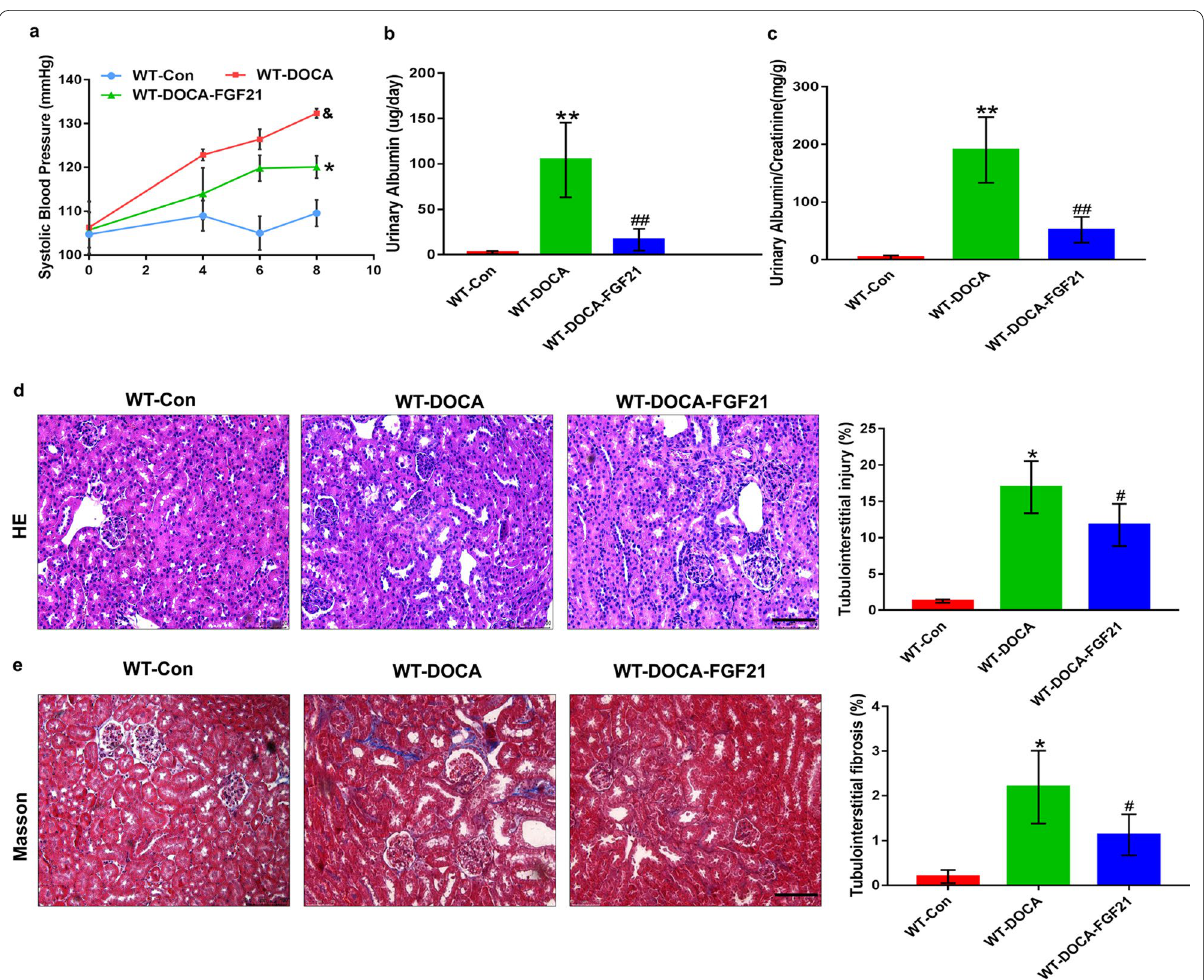
Fig. 3 Replenishment of rhFGF21 effectively protected mice from DOCA‑salt‑induced renal injury. Eight‑week‑old male WT mice were randomly divided into three experimental groups: the WT‑Control group treated with sham operation, followed by intraperitoneal injection with 0.9% normal saline; the WT‑DOCA group treated with DOCA‑salt; the WT‑DOCA‑FGF21 group treated with DOCA‑salt, followed by intraperitoneal supplementation of recombinant human FGF21 (rhFGF21, 500 μg/kg/day body weight). After 8 days of intervention, the serum and kidney tissues of mice in each group were harvested for detection. a Systolic blood pressure (mm Hg) was determined at the indicated days (from 0 to 8 day). b and c Urinary albumin (μg/day) and the ratio of urinary albumin/creatinine (mg/g) as indexes of renal function were determined. d Representative images of Hematoxylin–eosin staining in kidney tissues collected at 8 days post‑DOCA‑salt treatment and quantification of tubulointerstitial injury region using Image‑Pro plus 6.0 software. e The levels of fibrosis in kidney tissues harvested at 8 days post‑DOCA‑salt treatment was determined by Masson’s trichrome staining and quantification of fibrotic degree in tubulointerstitium using Image‑Pro plus 6.0 software. The values are expressed as the mean SD, n 6 mice/group. *P < 0.05 and **P < 0.01versus the WT control group; # P < 0.05 and ## P < 0.01 versus the WT‑DOCA group. Scale ± = bar: 100 μm